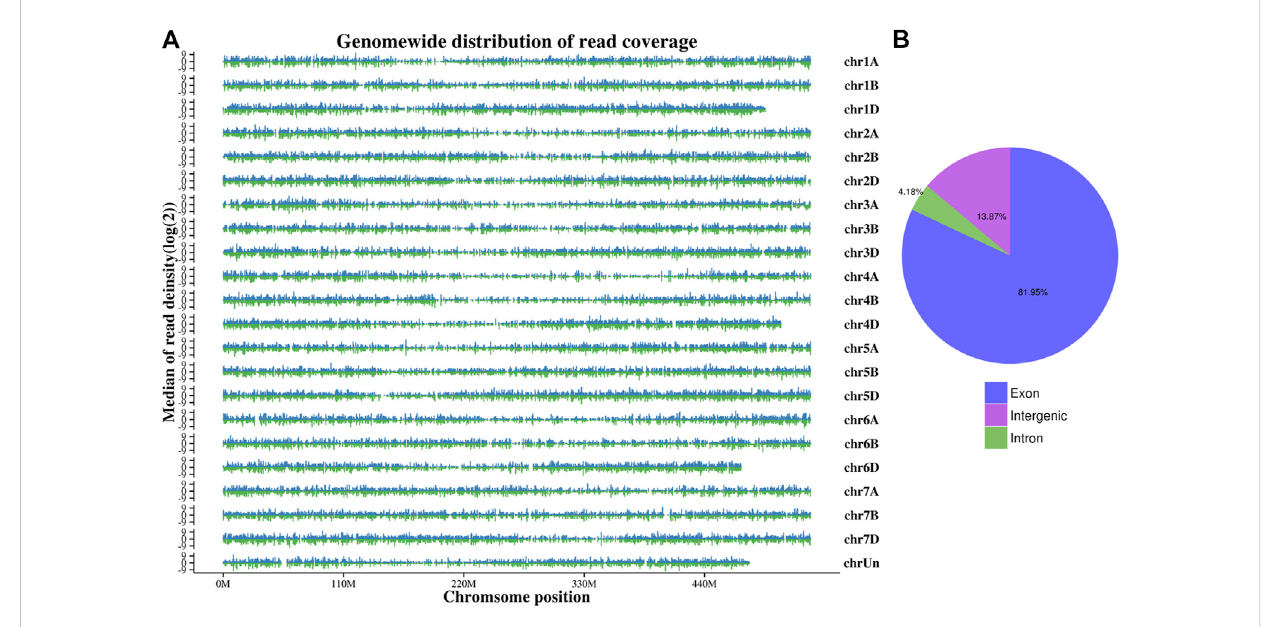
FIGURE 1 Whole-genome coverage (A) and gene read distributions (B) for K6G.